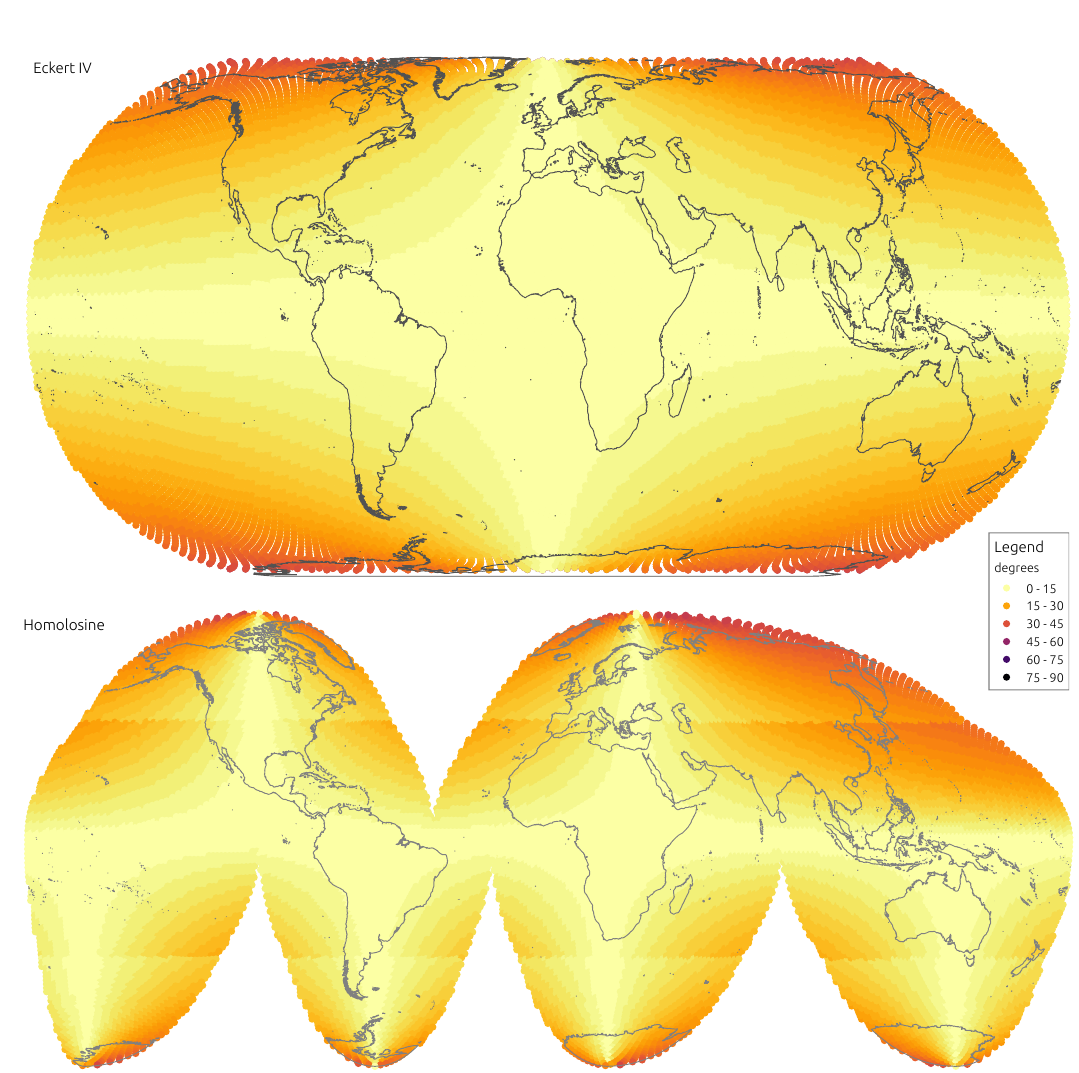
Figure 4. Mean absolute angular distortion at each indicatrix for the Eckert IV and Homolosine